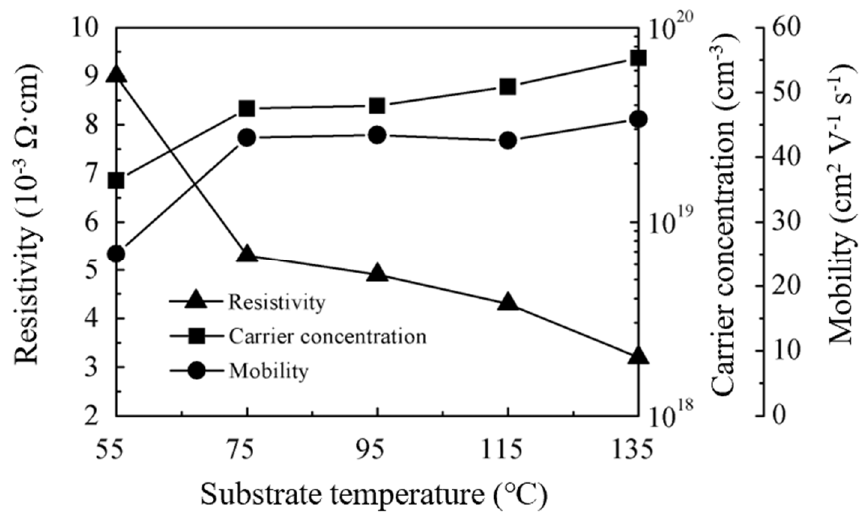
Figure 5. The variations of resistivity, carrier concentration ( N c ), and mobility ( µ ) for sALD-ZnO films with deposition